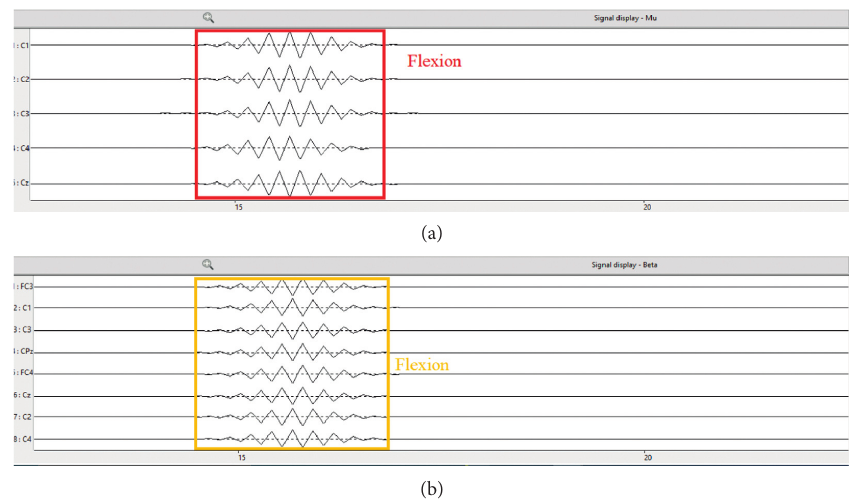
Figure 12: The behavior of the mu and beta rhythm at the flexion state.